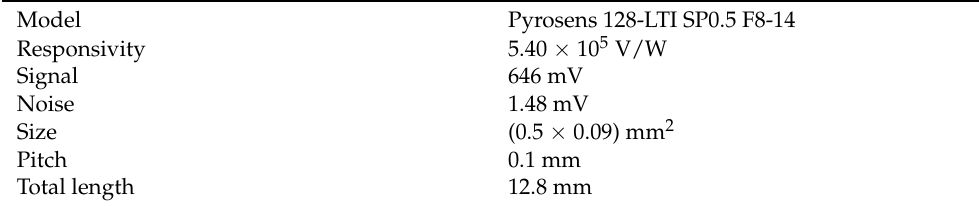
Table 7. Specifications of the spectrometer’s linear detector